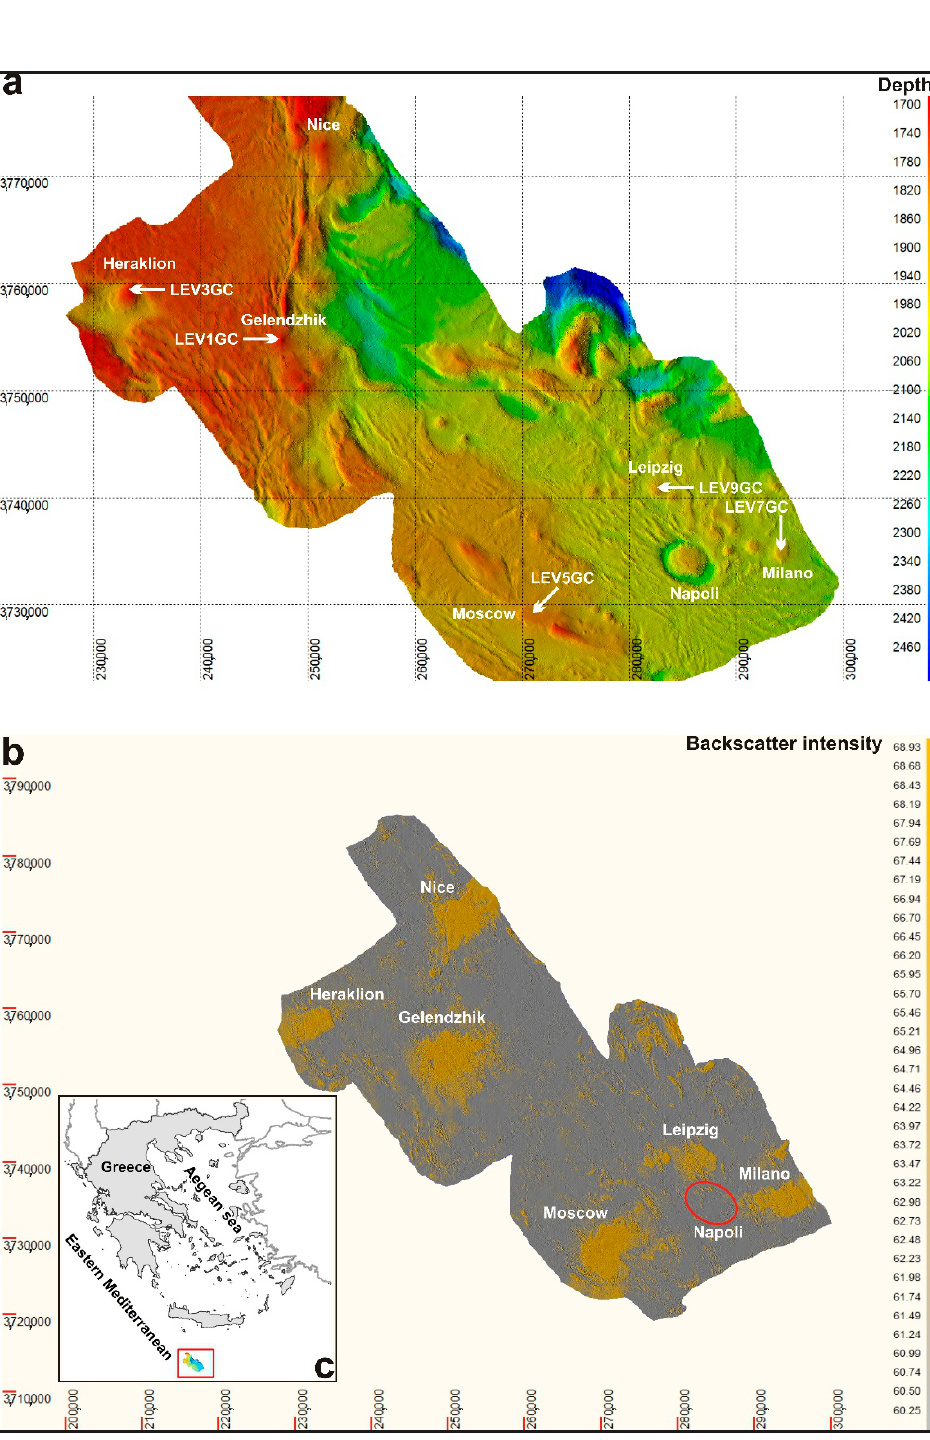
Figure 2. ( a ) Bathymetric digital terrain model of the Olimpi mud volcano field (grid interval: 50 m; ellipsoid: WGS84; projection: UTM35N; reference datum: mean sea level) and sediment coring locations (the core labels appear in white color). ( b ) Seabed reflectivity in the Olimpi mud volcano field (grid interval of 50 m), with the yellow-colored patches representing strong backscatter signal. ( c ) Location of the Olimpi mud volcano field (inset map). From Panagiotopoulos et al. [26].